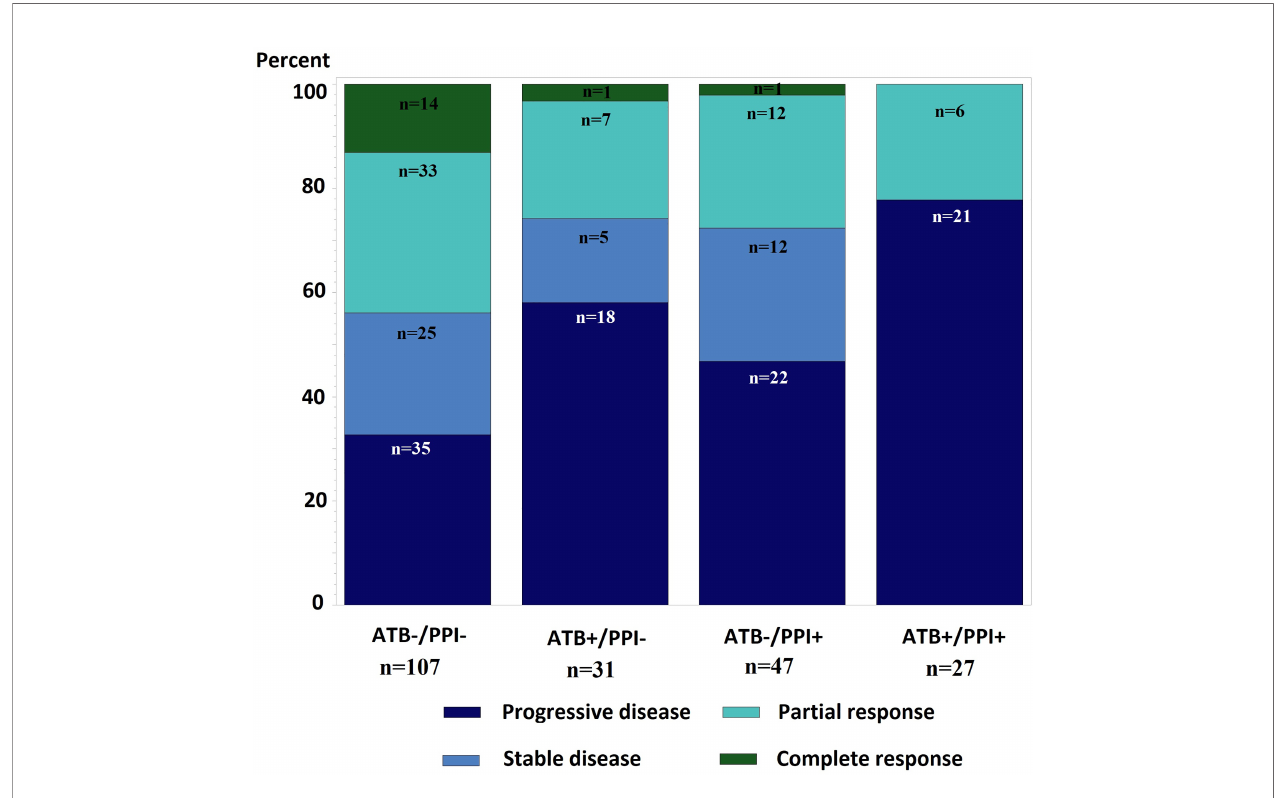
FIGURE 2 | Description of overall best response according to ATB and/or PPI